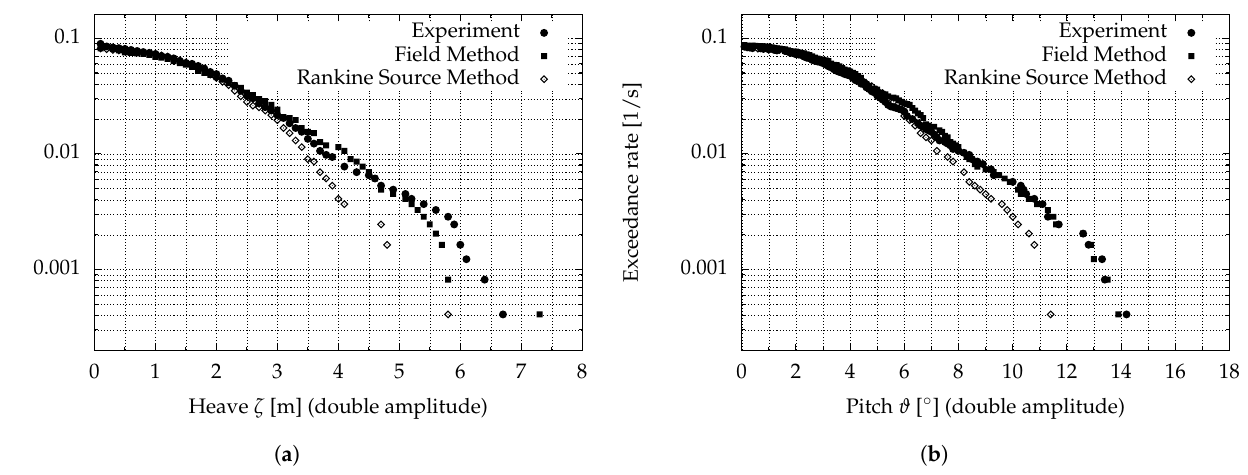
Figure 25. LNG carrier: short-term statistics of ( a ) heave and ( b ) pitch motions. Figure 26 shows a direct comparison of ship responses for the same sea states. Both ships were tested in different campaigns, but experienced the same waves (sea state realization). The pitch and heave motions are presented with absolute values. As expected maximum heave and pitch motions are remarkably stronger pronounced for the smaller chemical tanker and differ by about 19.4% and 17.1%, respectively. This trend is significant and starts at low response levels.